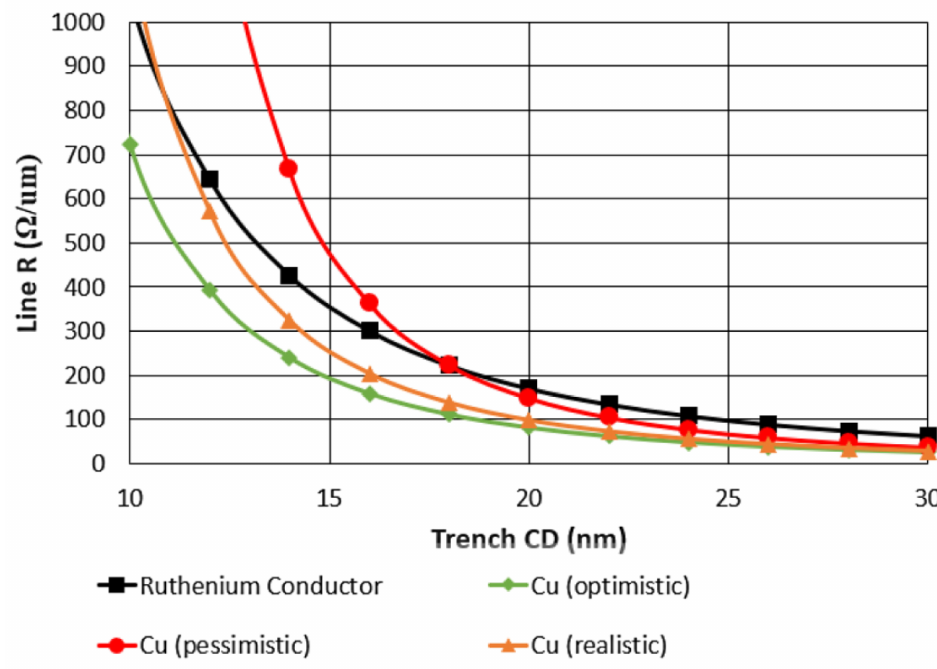
Figure 12. Theoretical trends of line resistance vs. line scale (i.e., trench CD) for Cu- and Ru-based interconnects. Reprinted with permission from Ref. [64]. 2020, American Vacuum